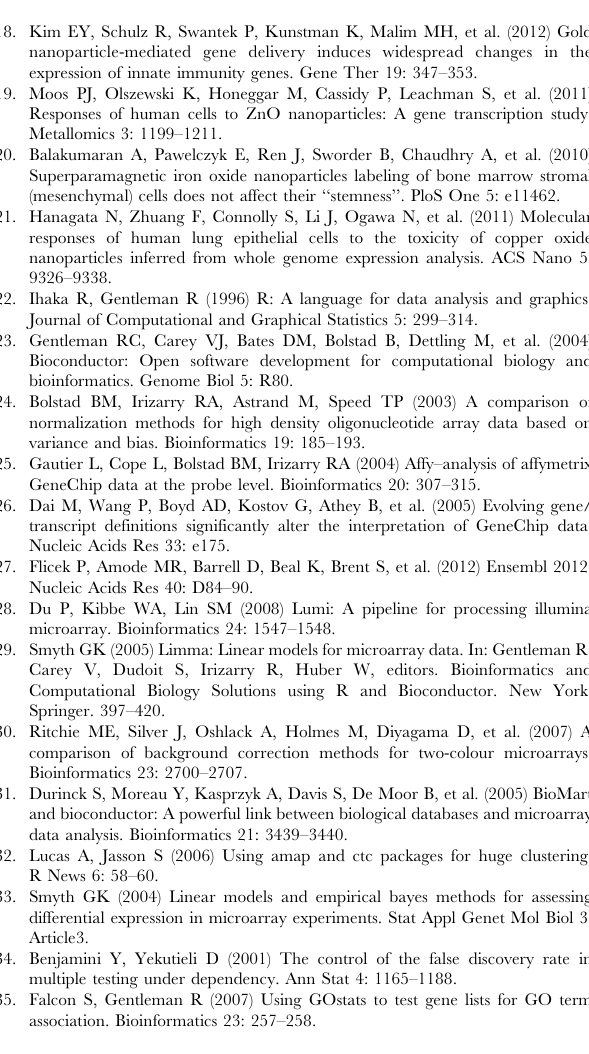
Table S4 The adjusted p-values of the genes within the GO:0006986 ‘‘response to unfolded protein’’ showing whether the gene is differentially expressed in the two comparisons of the ZnO treatments of HMDM samples within the data set GSE39330. By default, when the adjusted p-value # 0.05 the gene is considered to be differentially expressed between the treated and control samples. Table S5 The enrichment analysis results for the differentially expressed genes of GSE39330 HMDM samples. The genes differentially expressed (adjusted p-value # 0.05 and absolute fold change $ 1.5) at both timepoints were input to the enrichment analysis, and the enrichments were computed through the KEGG pathways, GO Biological Processes, GO Molecular Functions, GO Cellular Components. The result gives the p-value showing whether the term is significantly enriched, expected count of the genes within the term, the odds- ratio of the genes of the list within the term, the total number of the genes and the genes found in the list within the term.